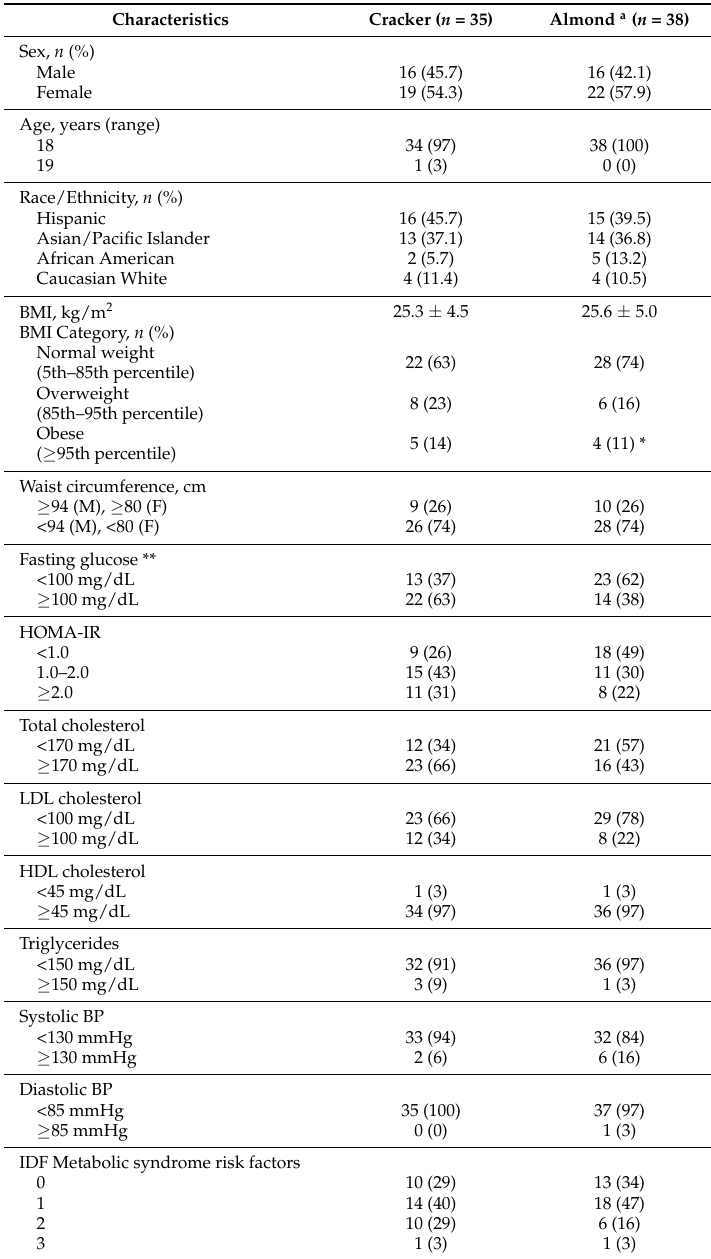
Table 1. Baseline demographic and clinical characteristics of participants in the cracker and almond